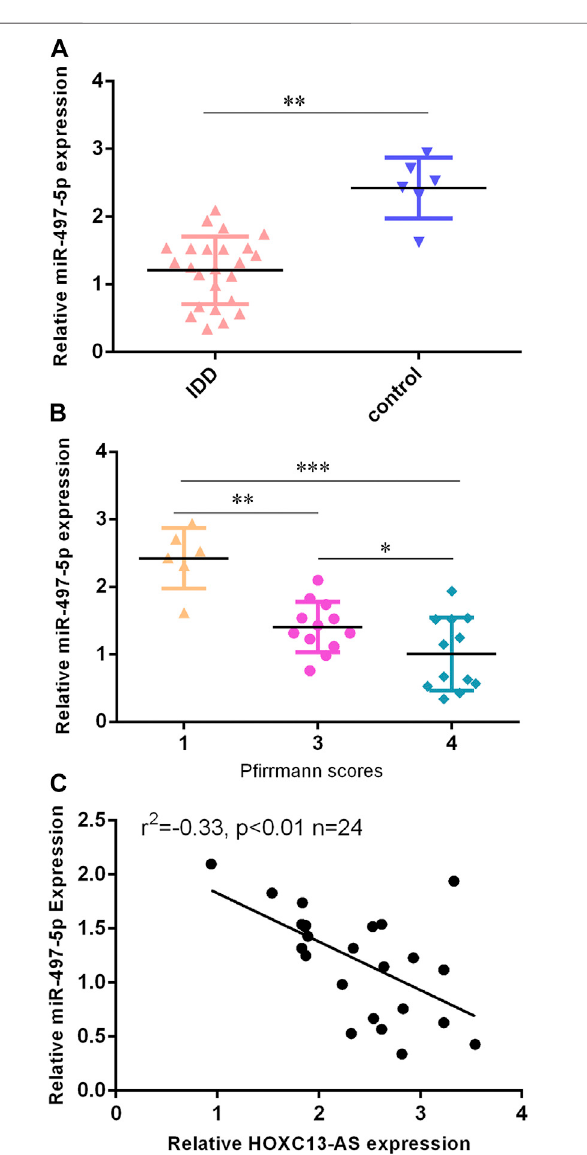
FIGURE 3 | miR-497-5p was downregulated in IDD specimens. (A) miR-497-5p was downregulated in IDD specimens compared to control specimens by RT-qPCR. (B) Lower expression of miR-497-5p was correlated with high P fi rrmann scores. (C) miR-497-5p expression was negatively proportional to HOXC13-AS expression in IDD specimens. * p < 0.05, ** p < 0.01, and *** p <